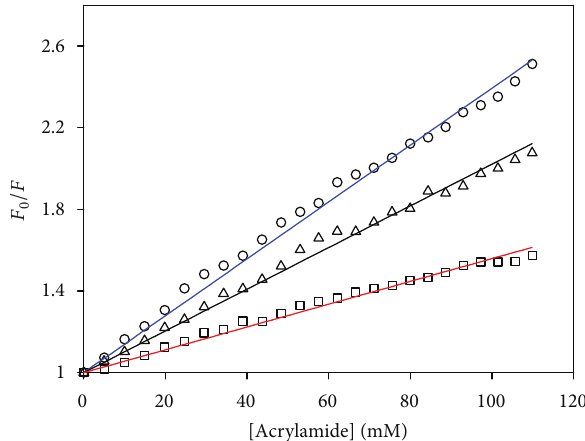
F8:Permeabilityoftheproteinstructureatroomtemperature. Fluorescence quenching experiments on psychrophilic (circles, blue) mesophilic (triangles, black), and thermophilic (squares, red) proteins. e steep slope recorded for the psychrophilic protein indicates that its structure is easily penetrated by a small quencher molecule (acrylamide), resulting in a larger attenuation of the , whereas the thermophilic protein is intrinsic �uorescence morerigid anddisplaysfewerinternalmotions. Adapted ( 𝐹𝐹 0 / 𝐹𝐹 )